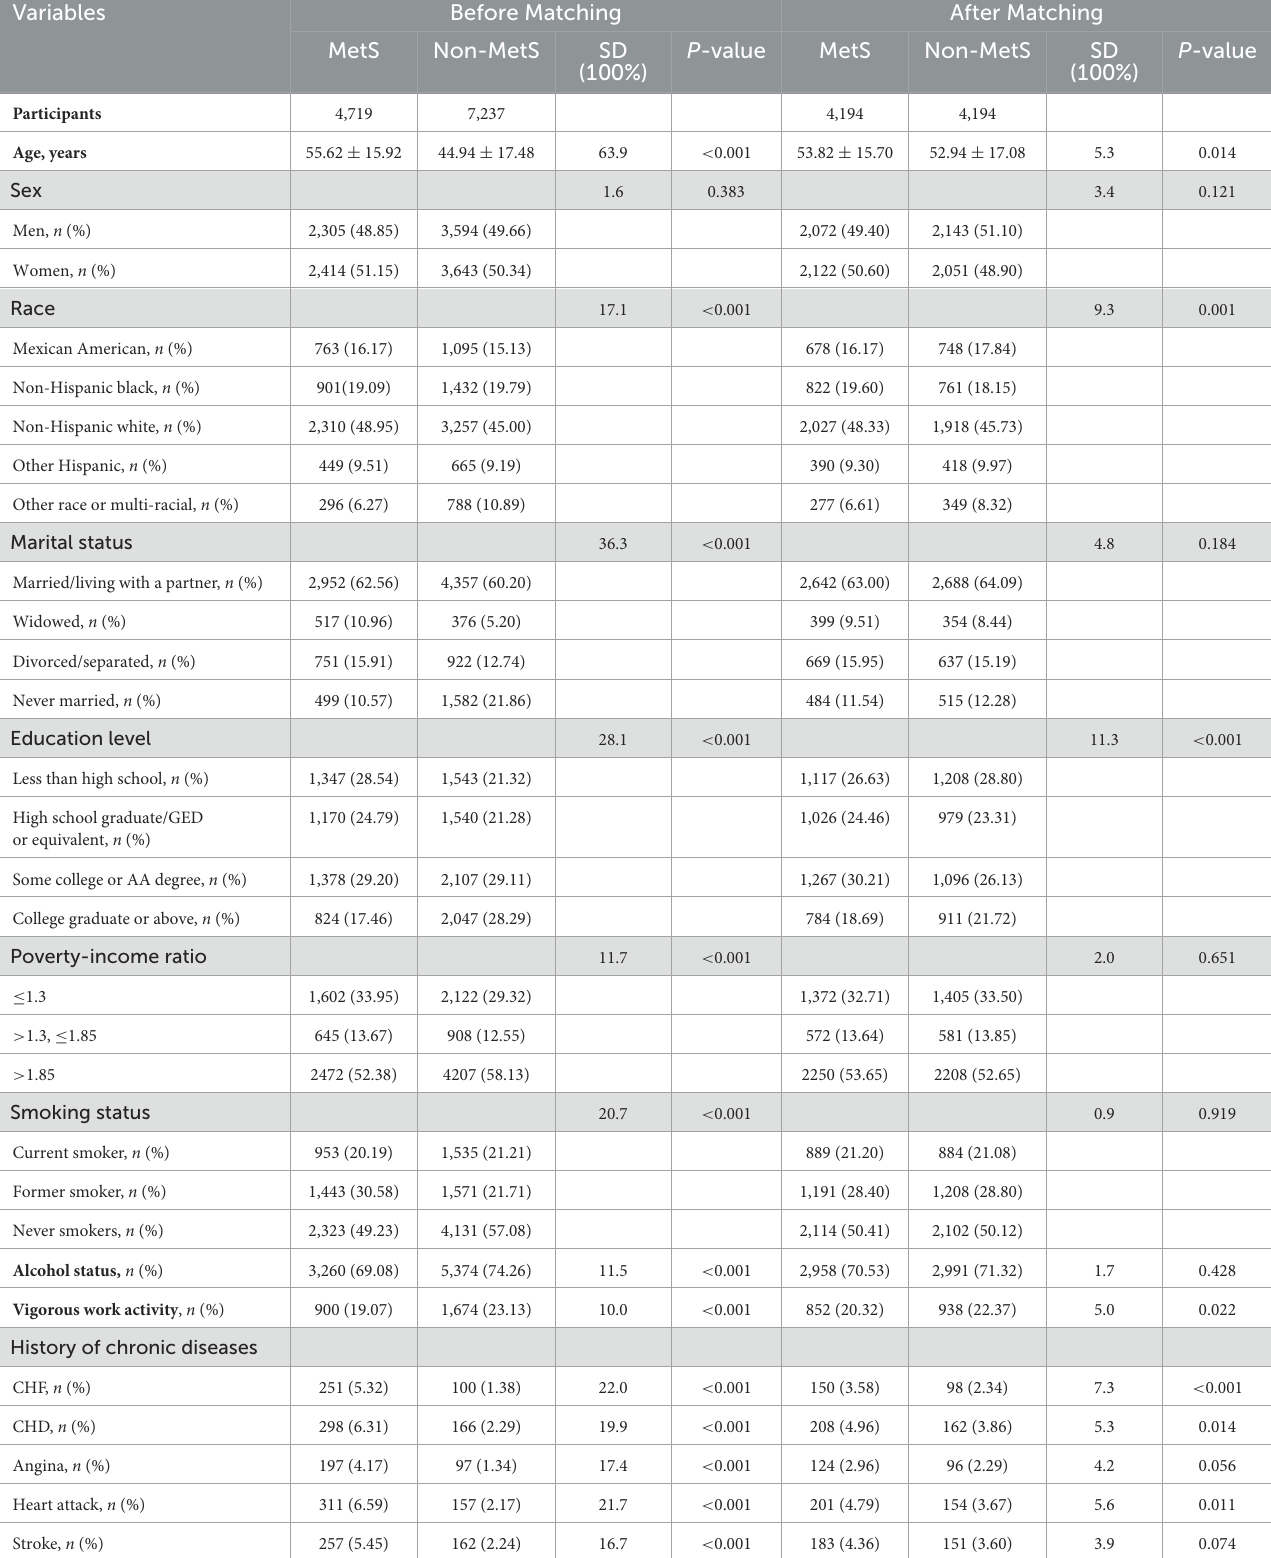
TABLE 1 Baseline characteristics of MetS and non-MetS participants before and after propensity score matching. Variables Before Matching After Matching MetS Non-MetS